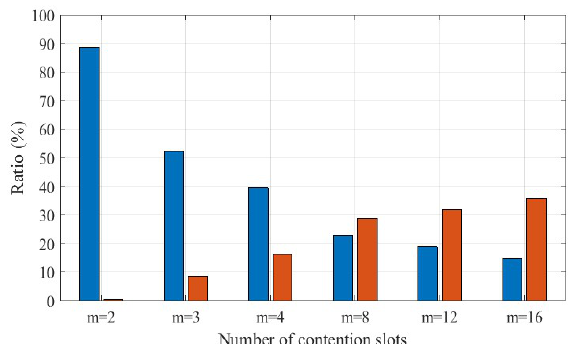
Figure 4. Access delay per sensor. Average collision resolution time (blue). Average data transmission time